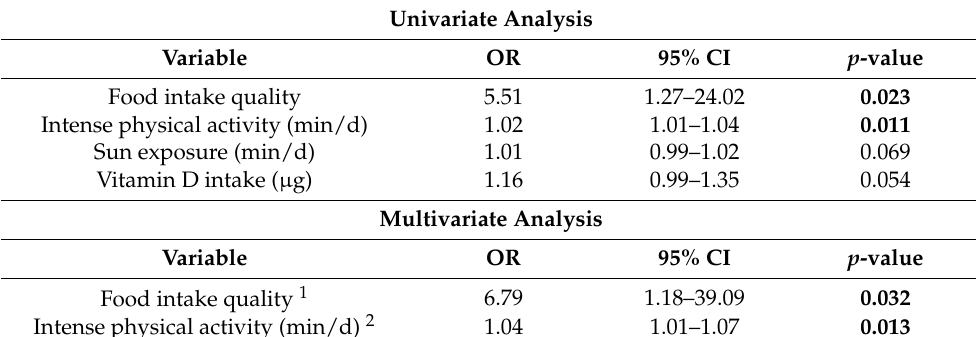
Figure 2. Prevalence of the recommended level in each item on the food intake quality questionnaire in patients with 25(OH)D insufficiency and sufficiency. Table 4. Association analysis of 25(OH)D insufficiency vs.